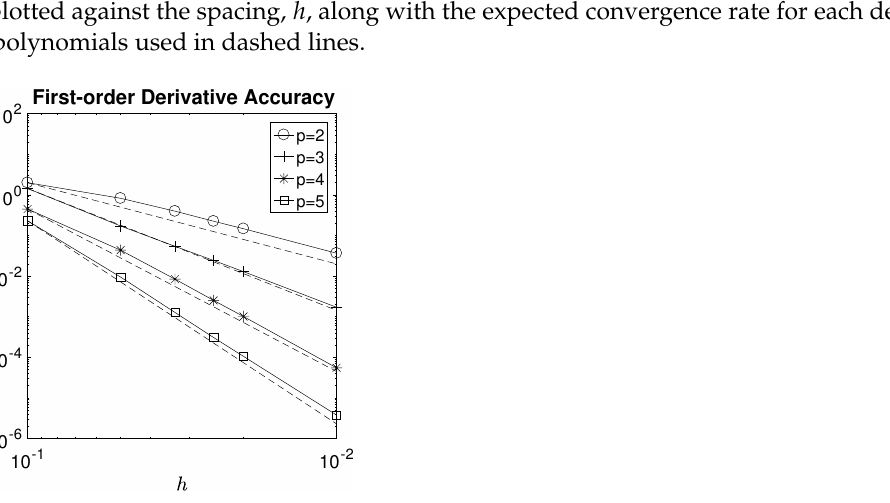
Figure 2. Convergence rates of a first-order derivative approximation using PHS and